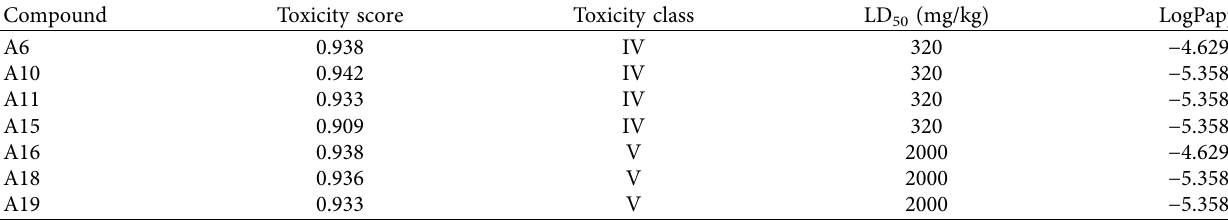
Table 5: Toxicity score and logPapp of top 7